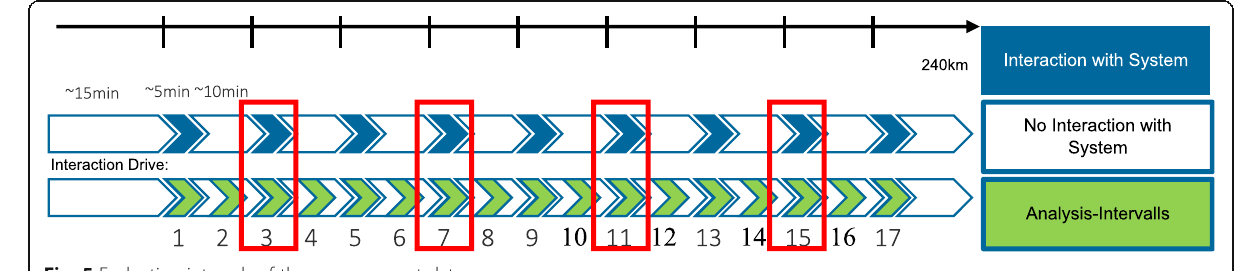
Fig. 5 Evaluation intervals of the measurement data